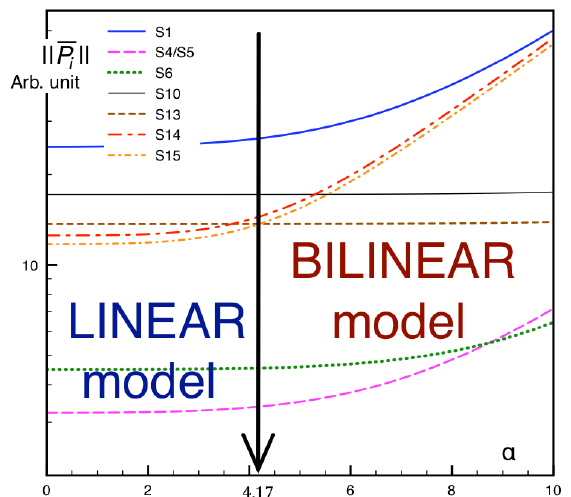
Figure 1. The Frobenius norm of sub-Gramians ˜ P i for generalized eigenmodes as a function of the weighting coefficient α in the test experiment in